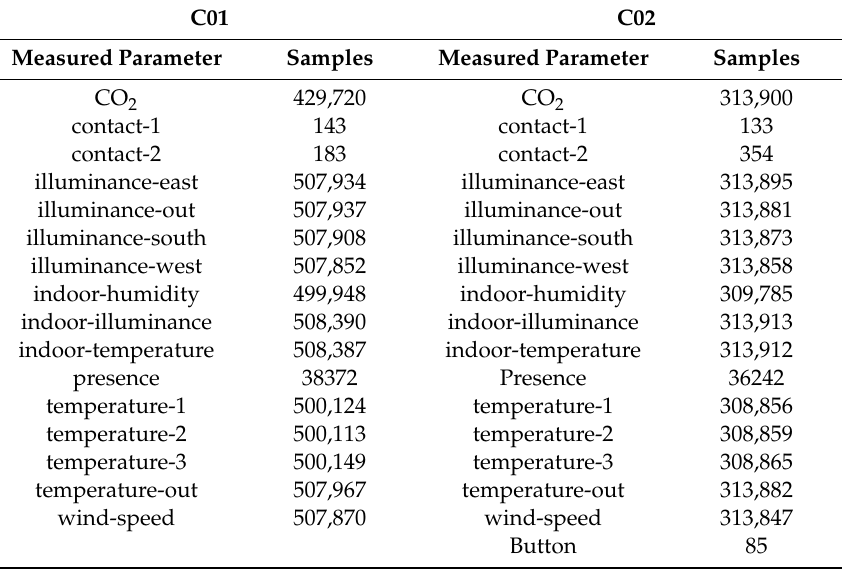
Table 3. Measurements and the respective number of collected